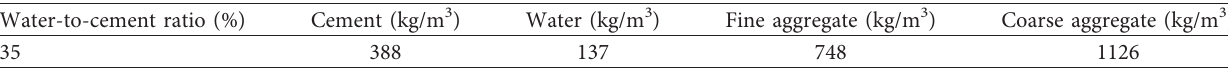
Figure 3: Layout of the reinforcement of the test beam (mm). Table 5: Mixing ratio of test beam concrete.